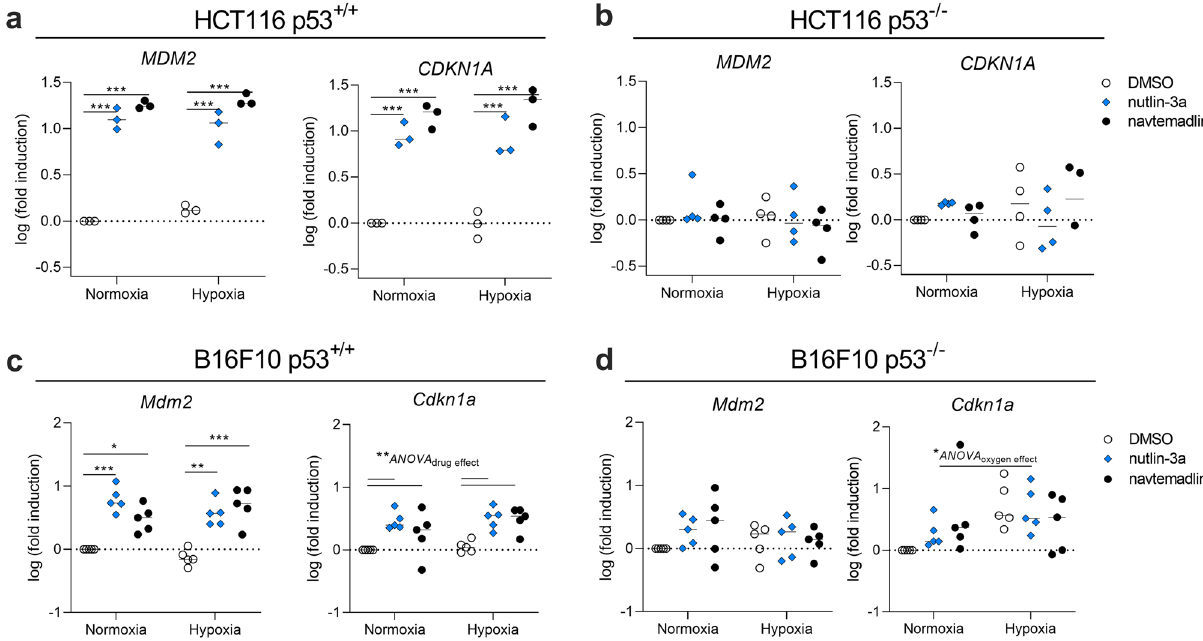
Figure 3. MDM2 inhibitors increase expression of downstream target genes of p53 in hypoxic p53 WT cancer cells. Gene expression was measured by qPCR in ( a, b ) HCT116 p53 +/+ and p53 −/− cells, and in ( c, d ) B16-F10 p53 +/+ and p53 −/− cells after 24 h treatment with MDM2 inhibitors. Human cells (HCT116) were treated with 2 µM nutlin-3a or 0.5 µM navtemadlin, while mouse cells (B16-F10) were treated with 10 µM nutlin-3a or 2 µM navtemadlin. Each data point represents averaged values of duplicates from three to five independent experiments. Expression was normalized to house-keeping genes B2M or Rplp0 for human or mouse cell lines, respectively. Statistical significance was assessed on non-log transformed dCT values using 2-way ANOVA *** P < 0.001). For Cdkn1a in c , d , values indicate the source of variation identified by the ANOVA (run prior to the post-hoc t test); post-hoc comparisons of each drug against DMSO did not provide significant values, likely due to insufficient